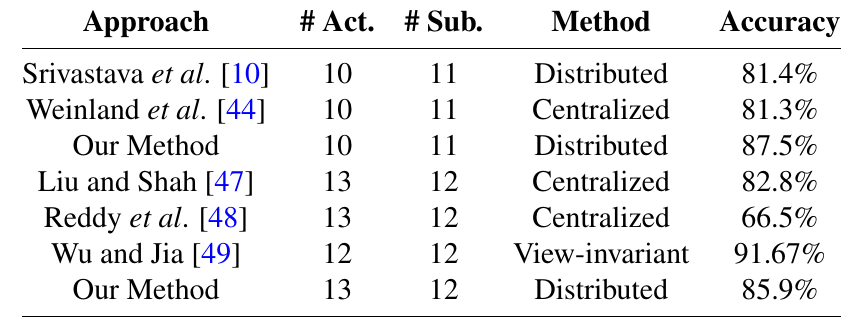
Table 1. Overall accuracy results on the IXMAS dataset, using all four cameras. # Sub. and # Act. in the table are the number of subjects and the number of actions taken into account for evaluation in the method, respectively.